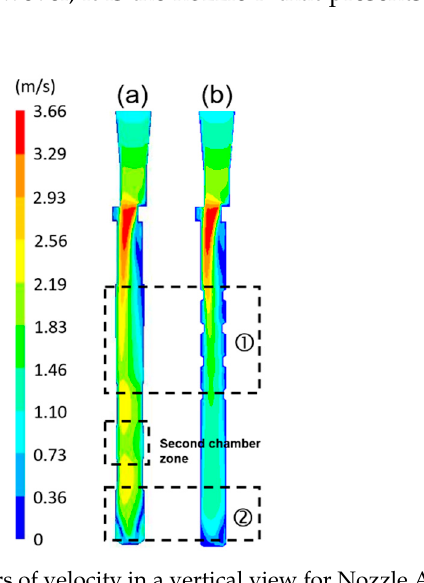
Figure 5. Touching inclusion percentage as function of the nozzle length for three inclusion sizes ( a ) Nozzle A and ( b ) Nozzle B.